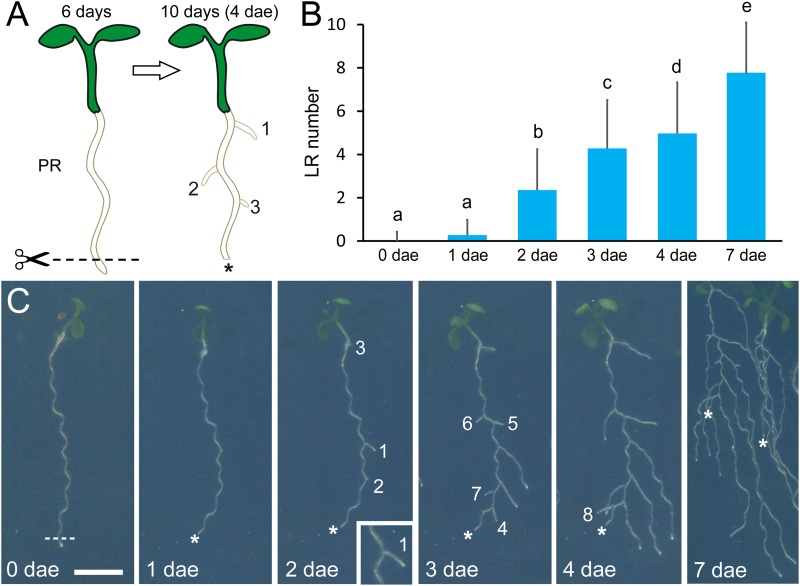
Wound-induced lateral root (LR) development. (A) Schematic representation of LR induction by root tip excision (the excision site is indicated by the scissors). dae, days after excision; PR, primary root. (B) Average LR number observed in the Columbia-0 (Col-0) reference accession after root tip excision. Different letters indicate significant differences (LSD, P-value < 0.01). (C) Time course of LR development in Col-0 after root tip excision. Scale bar: 5 mm. Numbers in (A,C) indicate order of LR emergence (1, first; 2, second; etc.). Asterisks mark the PR tips after excision.